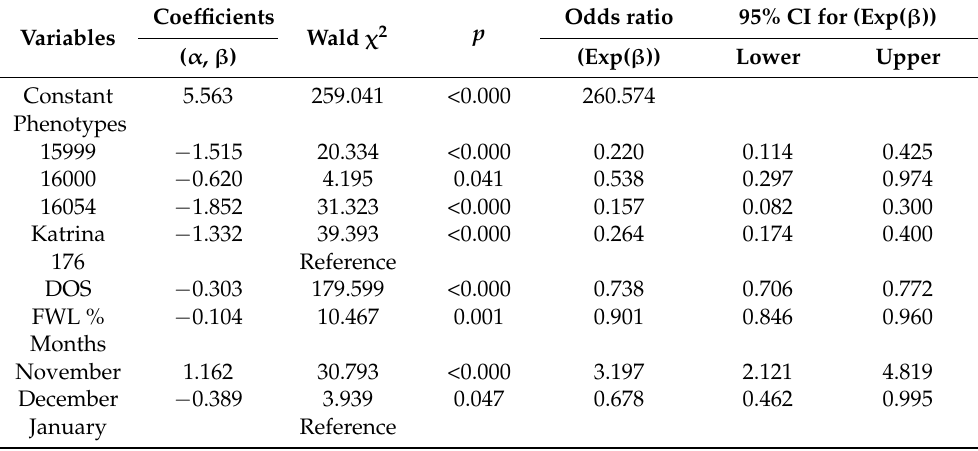
Table 13. Estimation of multiple logistic regression parameters for the 176, 15999, 16000, 16054, and Katrina cucumber